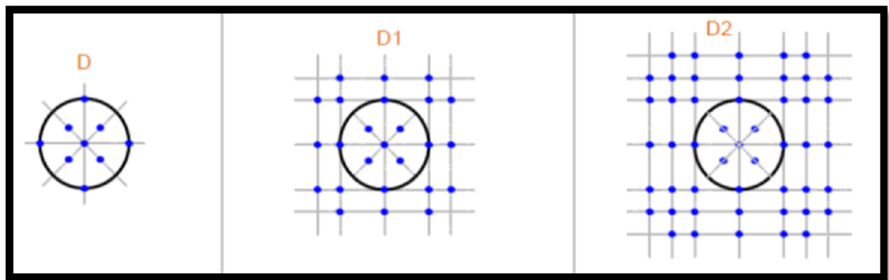
Figure 5: Spacing of grouting points with a depth of grouting equal to d ′ .